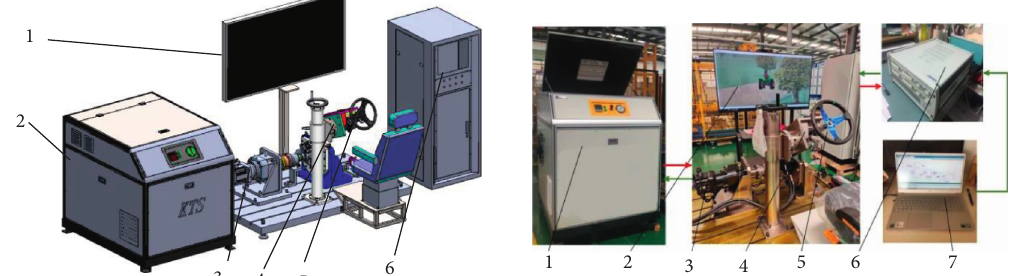
Figure 12: EPS hardware in the loop test bed.